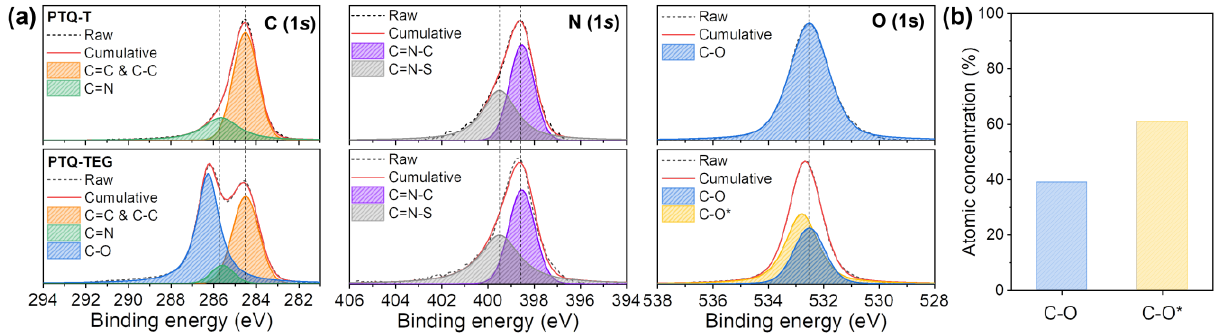
Figure 4. ( a ) Atomic binding-energy distributions of PTQ-T and PTQ-TEG and ( b ) comparison of intercalated O atoms in PTQ-TEG . “*” indicates the presence of O atoms having a higher binding energy compared to the pristine O atoms.